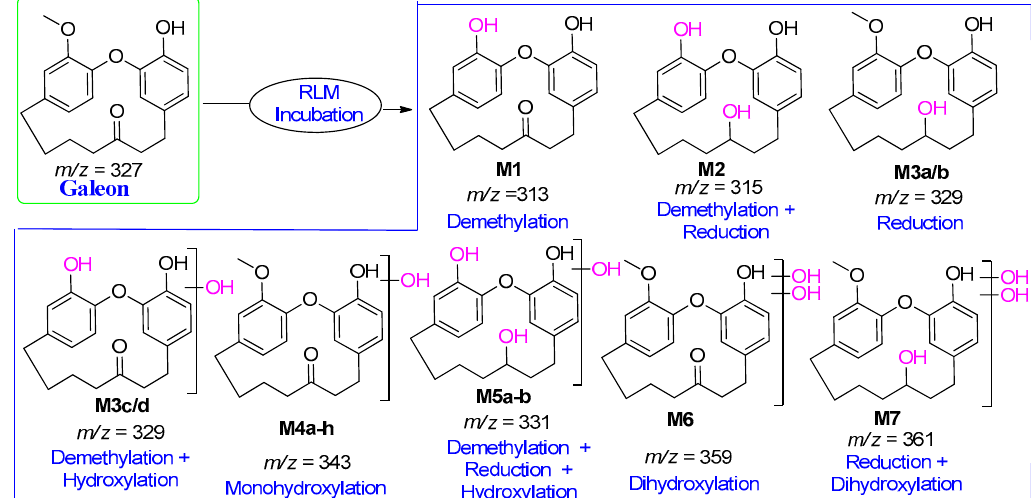
Table 3. Reactive metabolites of